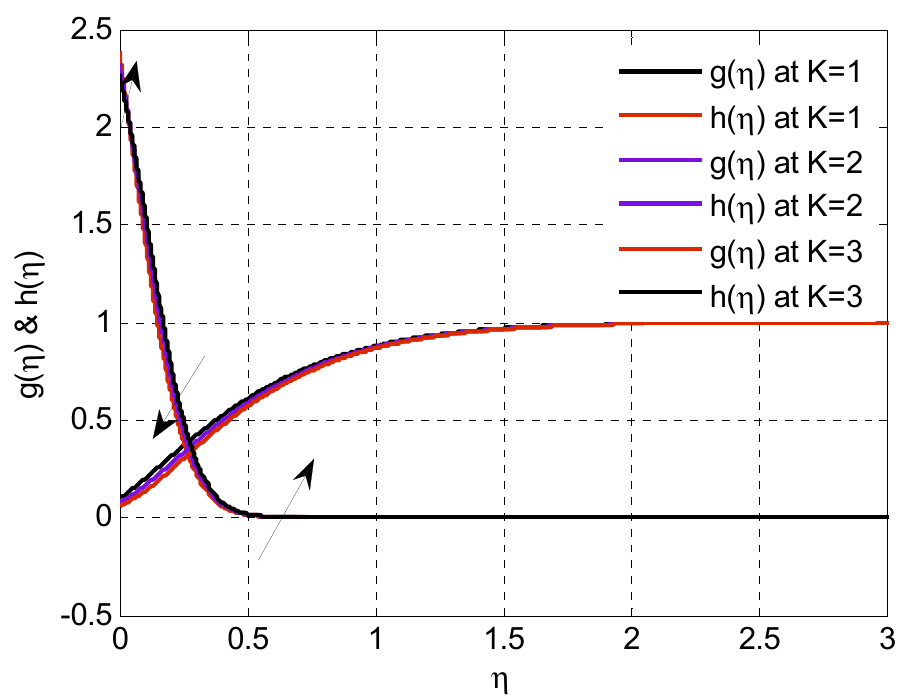
Figure 13. Effect of homogeneous reaction parameter on concentration profiles of species 𝐴 and 𝐵 using G = 1, K b = 1, λ = 0.5, F r = 0.1, K 2 = 0.1, δ = 0.1, S c = 4, and N = 3040.